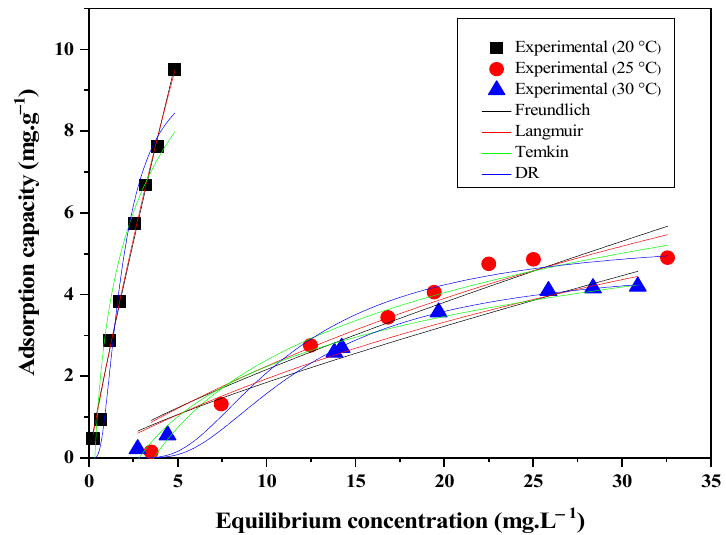
Figure 10. Adsorption isotherms observed for 10 g · L − 1 CaSF using different MR concentrations and stirring the system at 100 rpm for 30 min.